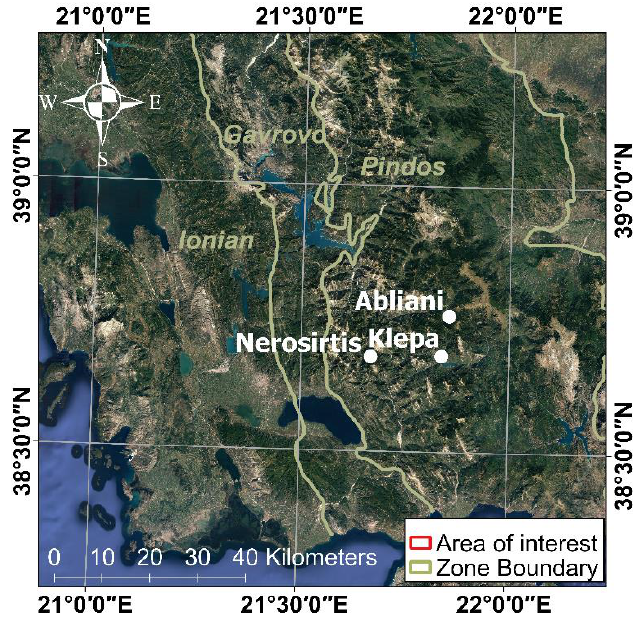
Figure 1. The area of interest marked in red rectangle and the geotectonic zones boundaries.